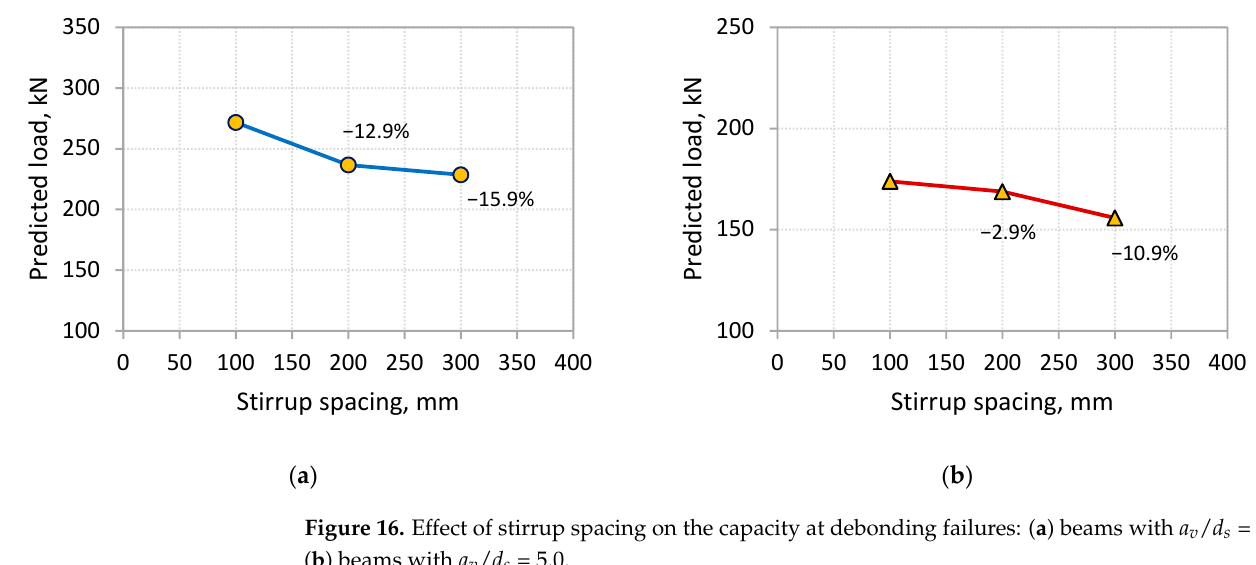
Figure 16. Effect of stirrup spacing on the capacity at debonding failures: ( a ) beams with a v / d s = 2.5; ( b ) beams with a v / d s = 5.0.